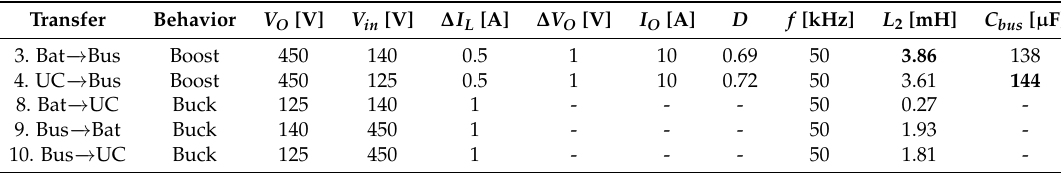
Table 4. Sizing of the power elements of the multiple-input